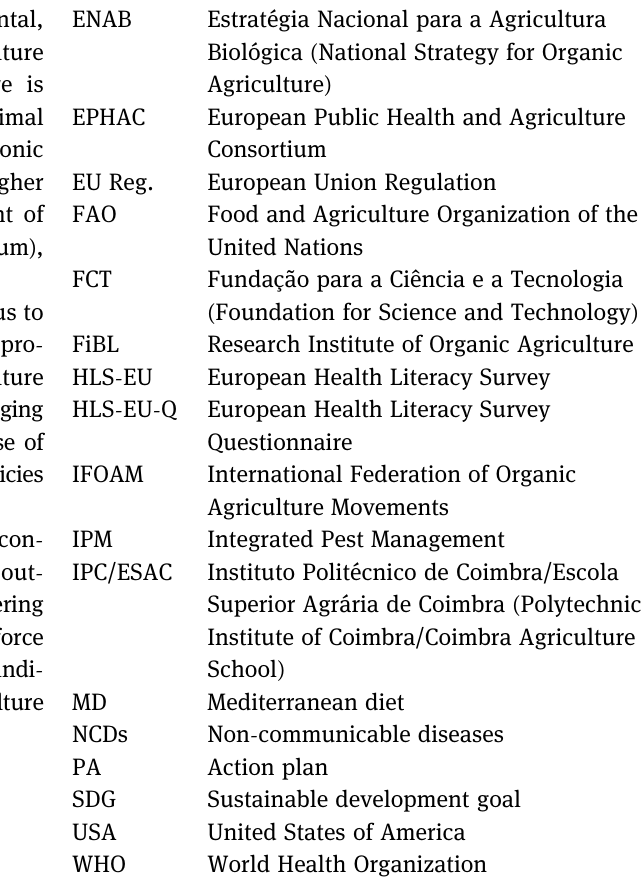
Acknowledgments: Figure 2 was elaborated with the sup